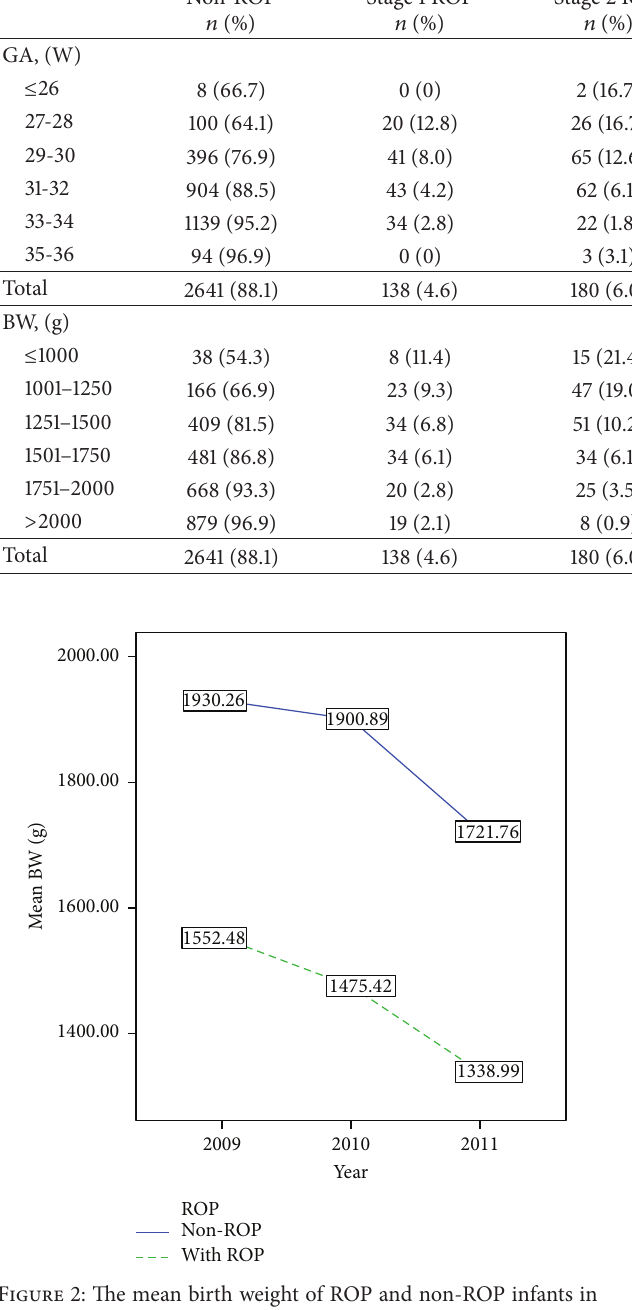
missed, but none of them had type I ROP. According to the US criteria (GA ≤ 30 weeks and/or BW ≤ 1500 g), 1922 infants did not require screening; thus the screening number was reduced by 66.5%. However, 118 ROP infants were missed including ten infants with type I ROP. In 2011, one infant with type I ROP was missed.